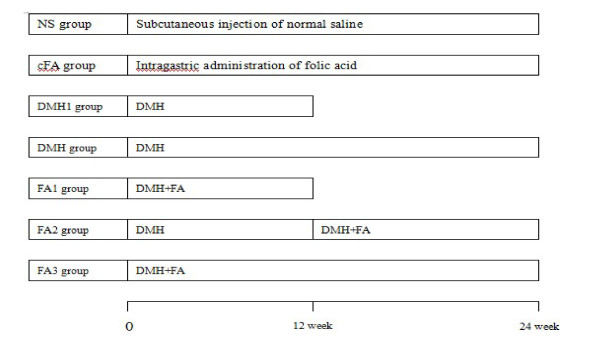
Groups of this study. NS group = Subcutaneous injection of physiological saline; DMH1 group = Subcutaneous injection of DMH for 12 weeks; DMH group = Subcutaneous injection of DMH for 24 weeks; cFA (control Folic Acid) = only intragastric administration of folic acid without DMH injection; FA1 = intragastric administration of folic acid with DMH injection for early 12 weeks; FA2 = intragastric administration of folic acid with DMH injection for later 12 weeks; FA3 = intragastric administration of folic acid with DMH injection for 24 weeks.